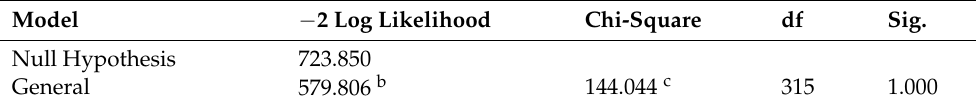
Table A5. Test of parallel lines a